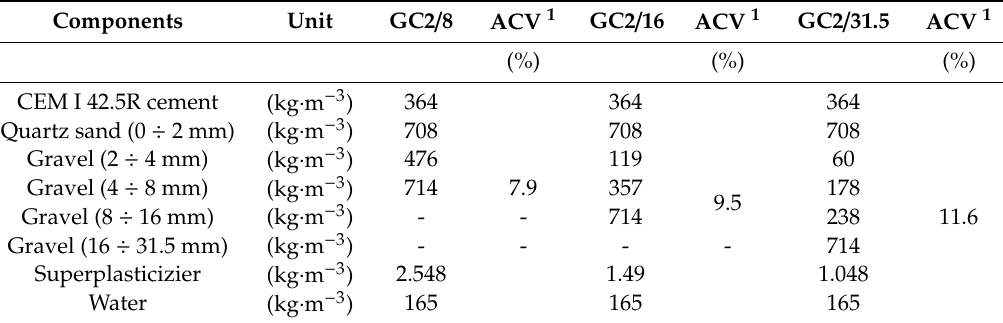
Table 4. Composition of concrete